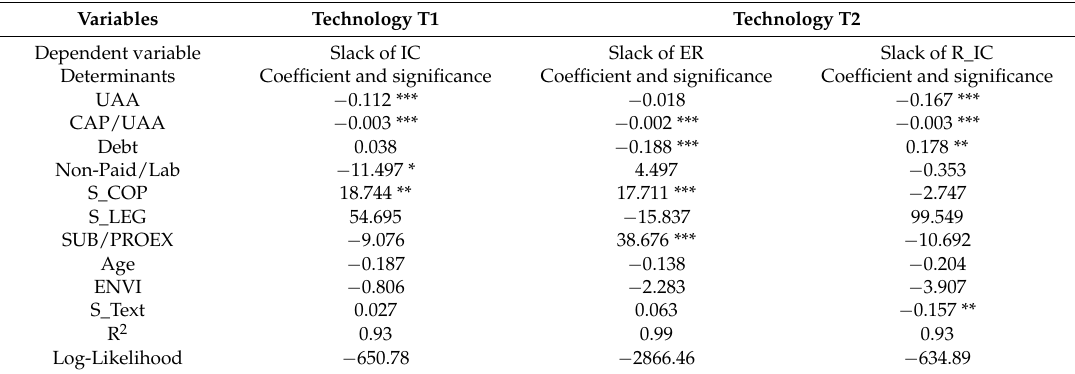
Table 11. Determinants of input slacks for dairy